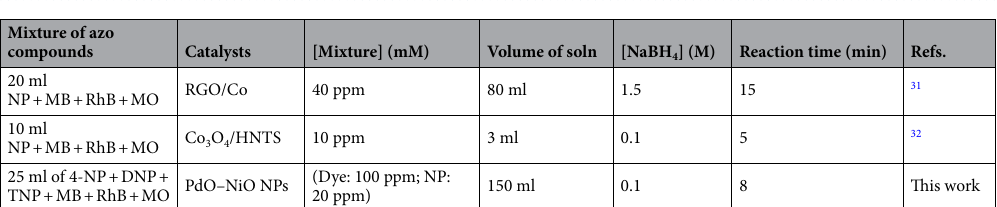
Mixture of azo compounds Catalysts [Mixture]